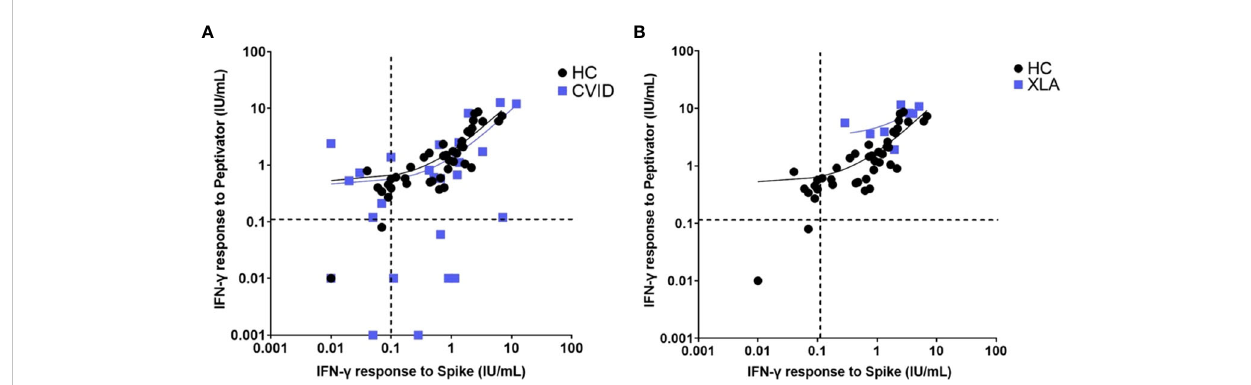
FIGURE 5 Interferon gamma levels post peptide mix and spike protein stimulation in (A) . healthy controls and patients with common variable immunode fi ciency and (B) . healthy controls and individuals with x-linked agammaglobulinaemia. Individual values are plotted on a logarithmic scale (log 10). The dashed lines represent the lower limit of the validated reference range (0.11IU/ml). The solid lines depict the lines of regression.